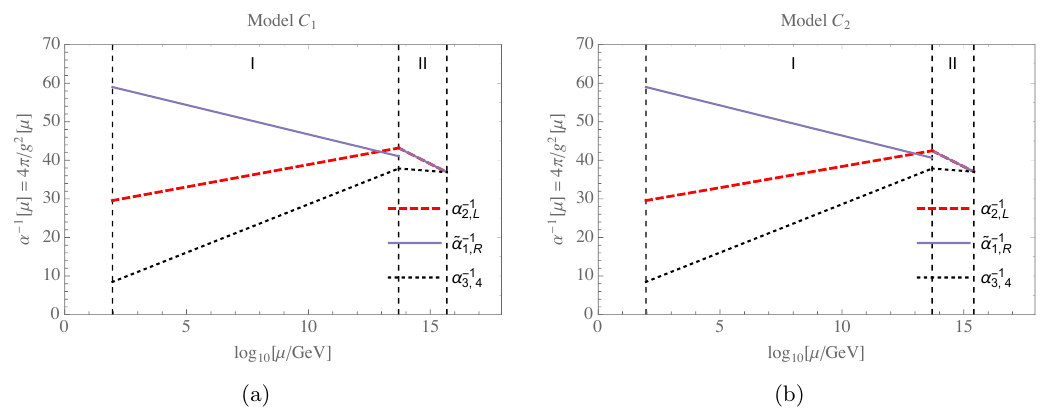
Figure 5 . Running of the gauge couplings for models C 1 , and C 2 . The vertical dotted lines correspond to the electroweak scale M Z , M C , and the uni(cid:12)cation scale M U . Note again that (cid:11) (cid:0) 1 (cid:17) 3 (cid:11) (cid:0) 1 e 1 1 5